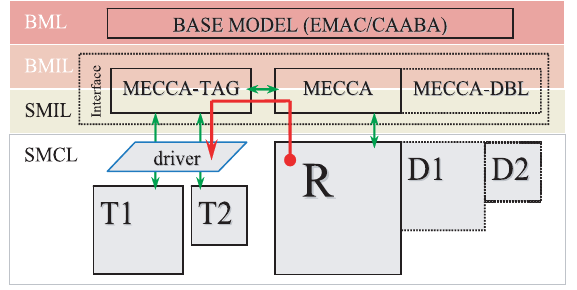
Fig. 8. Schematic of the MECCA-TAG and MECCA-DBL principal structure (SMCL level is detailed). The regular simulated mechanism (R) provides one-way information on the tagged reaction rates and species budgets to the MECCA-TAG driver. Further each configuration (T1, T2) uses approximated rates to advance the tagged species. Additional species and reactions of the doubling configurations (D1, D2) are added to the regular mechanism, thus MECCA-DBL is just an extension of